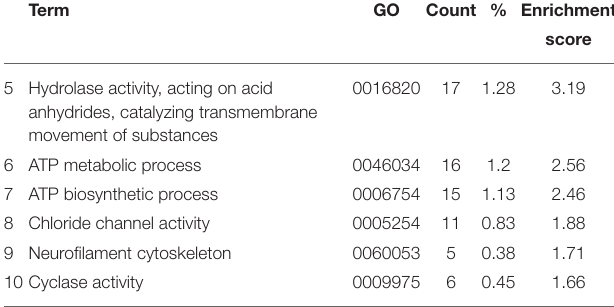
TABLE 1 | Enrichment analysis of transcripts differentially expressed in both the (A) symptomatic and (B) late-stage time-points in SOD1 G93A astrocytes vs. NTg controls ( p ≤ 0.05 , FC ≥